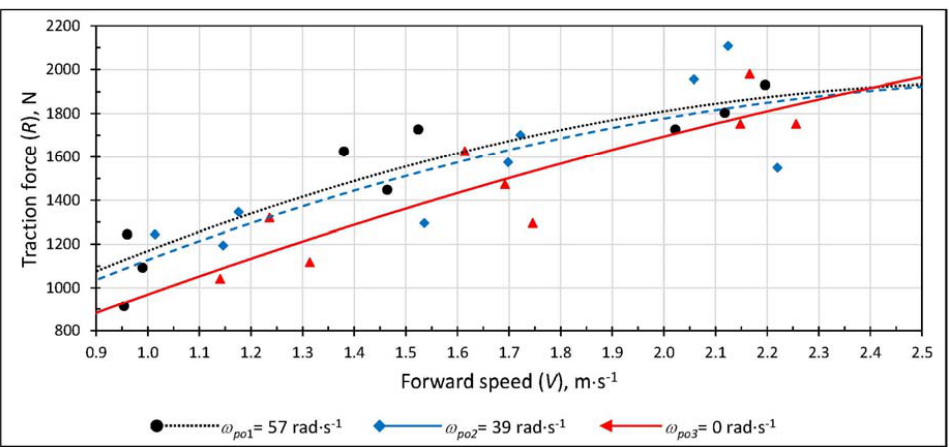
Figure 5. Tractor traction force R vs. aggregate tractor – beet top harvester forward speed V for different values of screw conveyor drive shaft angular speed. Energies 2020 , 13 , x FOR PEER REVIEW